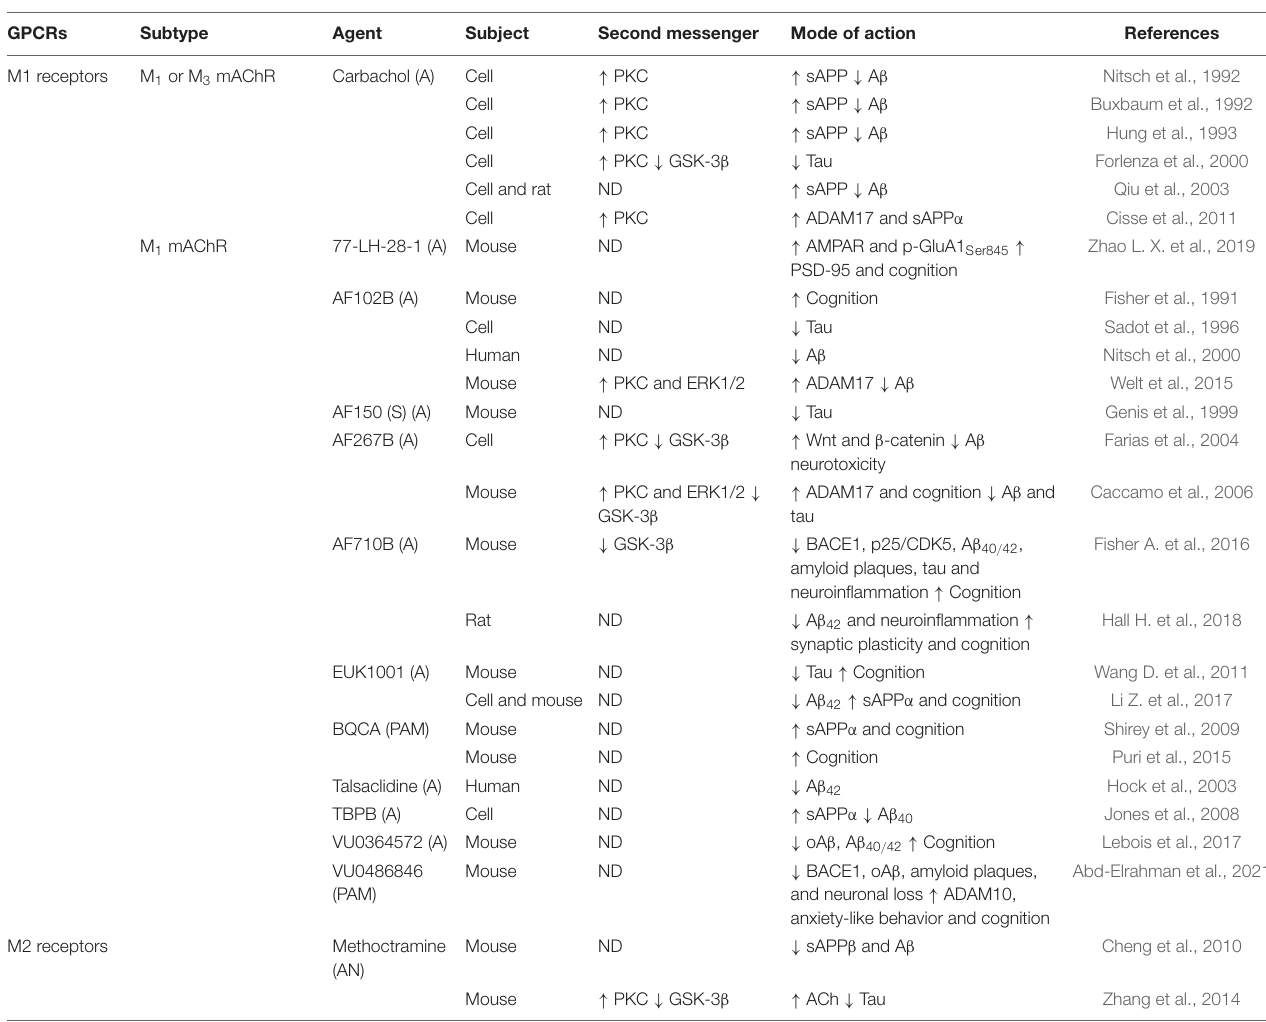
TABLE 1 | Muscarinic acetylcholine receptors reported to be involved in Alzheimer’s disease.